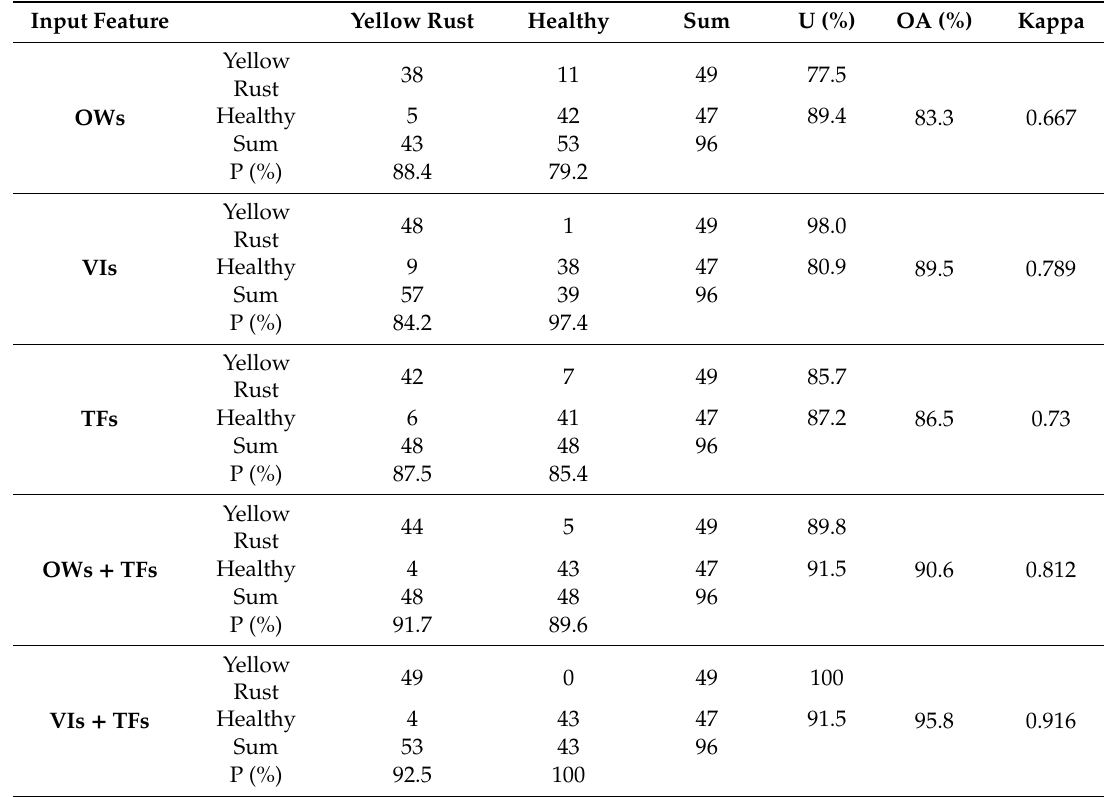
Table 5. Comparison of the results of the identification model using the support vector machine (SVM) based on di ff erent